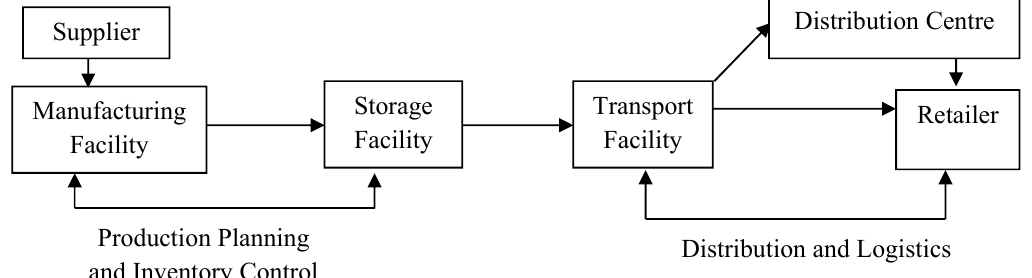
Fig. 1. Supply-chain process(Benita & Beamon,